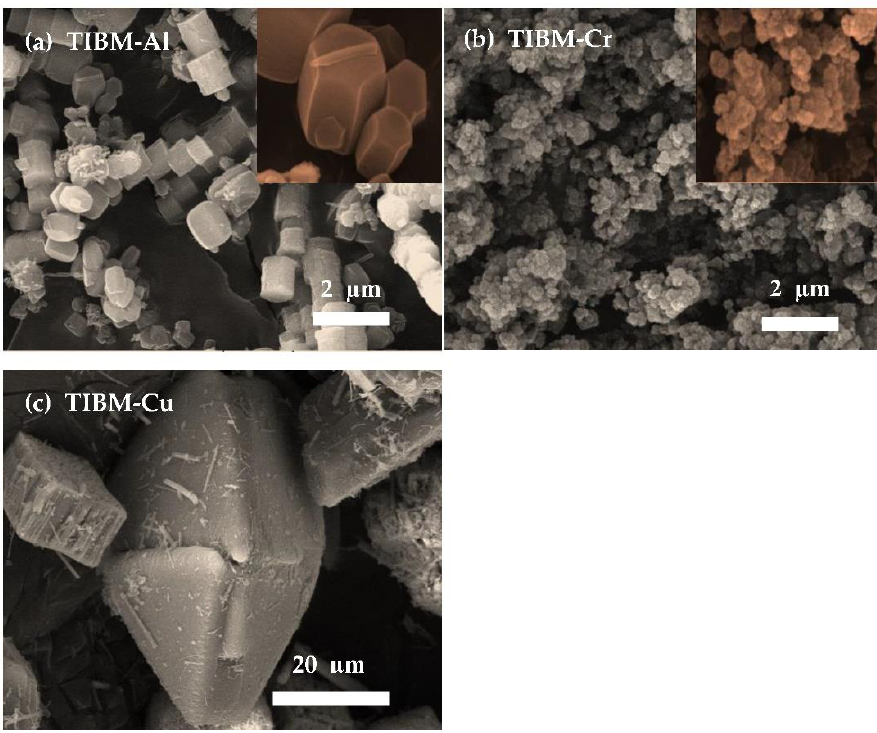
Figure 2 . SEM images of ( a ) TIBM-Al, ( b ) TIBM-Cr, and ( c )